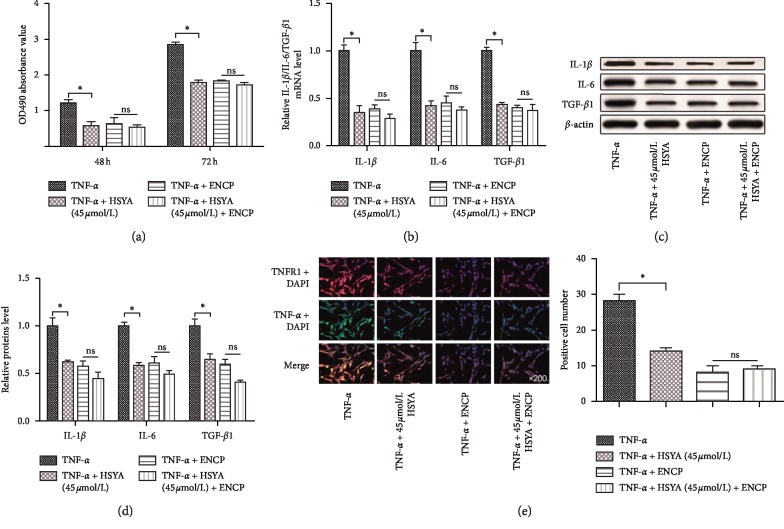
HSYA competes with TNF-α to bind with TNFR1. (a) MTT assay was used to detect the proliferation of TNF-α stimulated MRC-5 cells; (b) quantitative RT-PCR was used to detect mRNA expression levels of IL-1β, IL-6, and TGF-β1; (c-d), western blot was used to detect the protein expression levels of IL-1β, IL-6, and TGF-β1; (e) immunofluorescence was used to detect the colocalization of TNF-α and TNFR1; HSYA, hydroxysafflor yellow A; ∗P < 0.05; ∗∗P < 0.01.